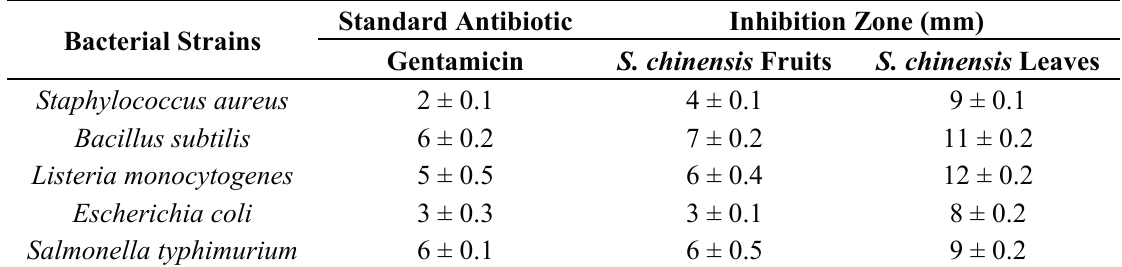
Table 5. Antibacterial activity of S. chinensis extracts and antibiotic against bacterial species tested by disc diffusion